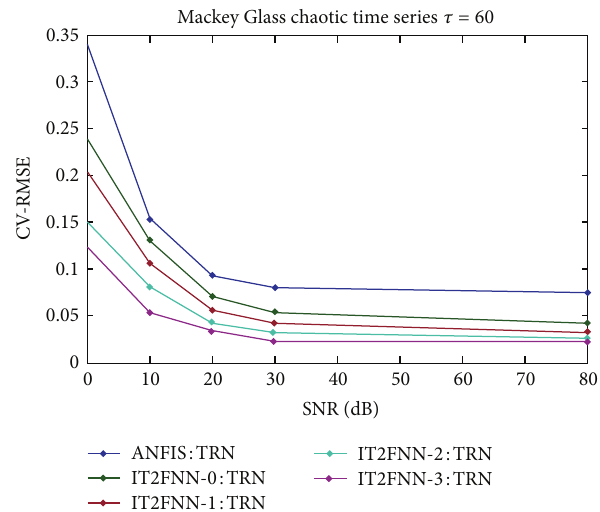
Figure 9: RMSE (TRN) values determined by ANFIS and IT2FNN models with 10-fold cross-validation for Mackey-Glass chaotic time series prediction with 𝜏 = 60